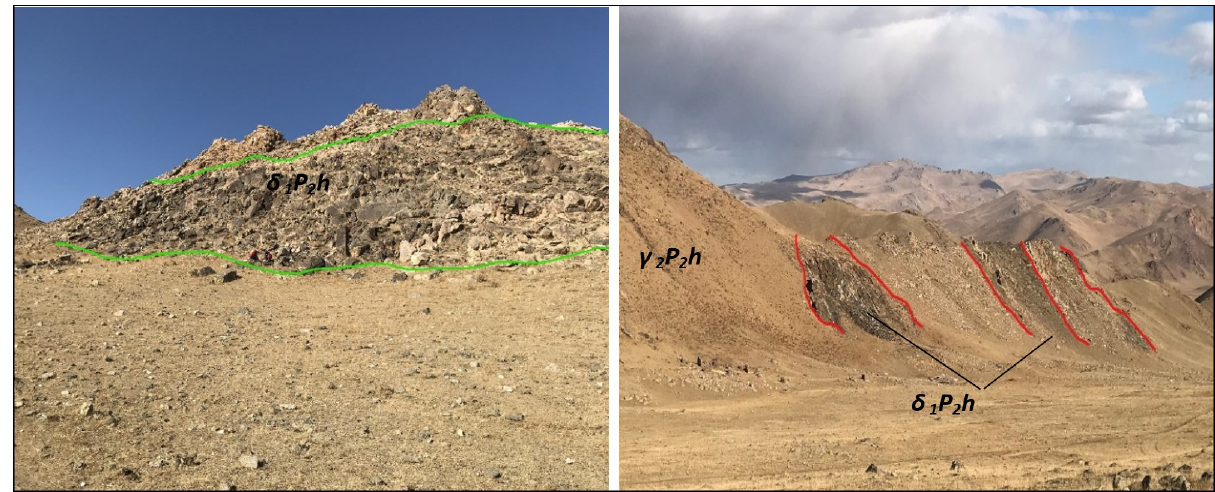
Fig. 3. Outcrop of the first phase diorite of Taatsiin Gol pluton Khangai